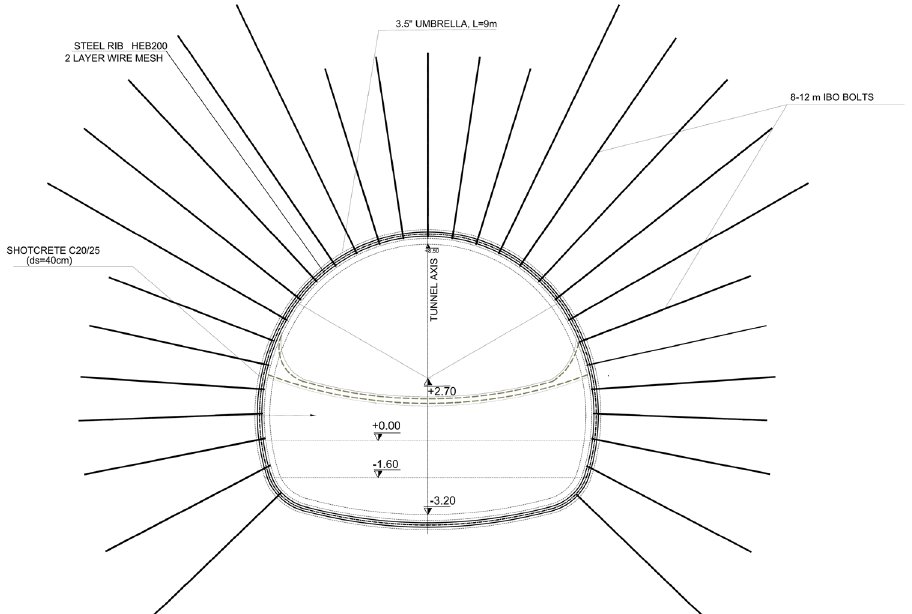
Figure 13. C3 support details.